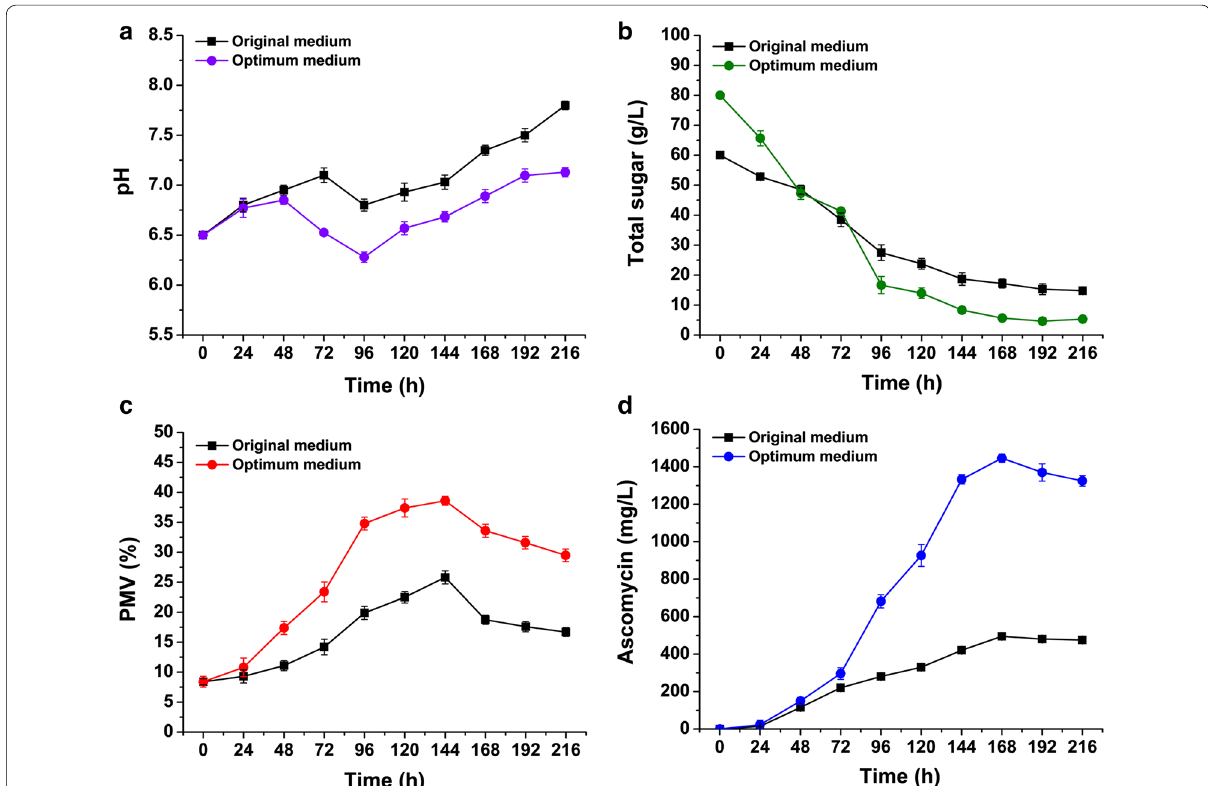
Fig. 5 Comparison of fermentation process between optimized medium and original medium by S. hygroscopicus SFK-36 in flask culture. Changes of pH ( a ), consumption of carbon source ( b ), time course of growth ( c ), and ascomycin accumulation ( d ) of SFK-36 in optimized medium and original